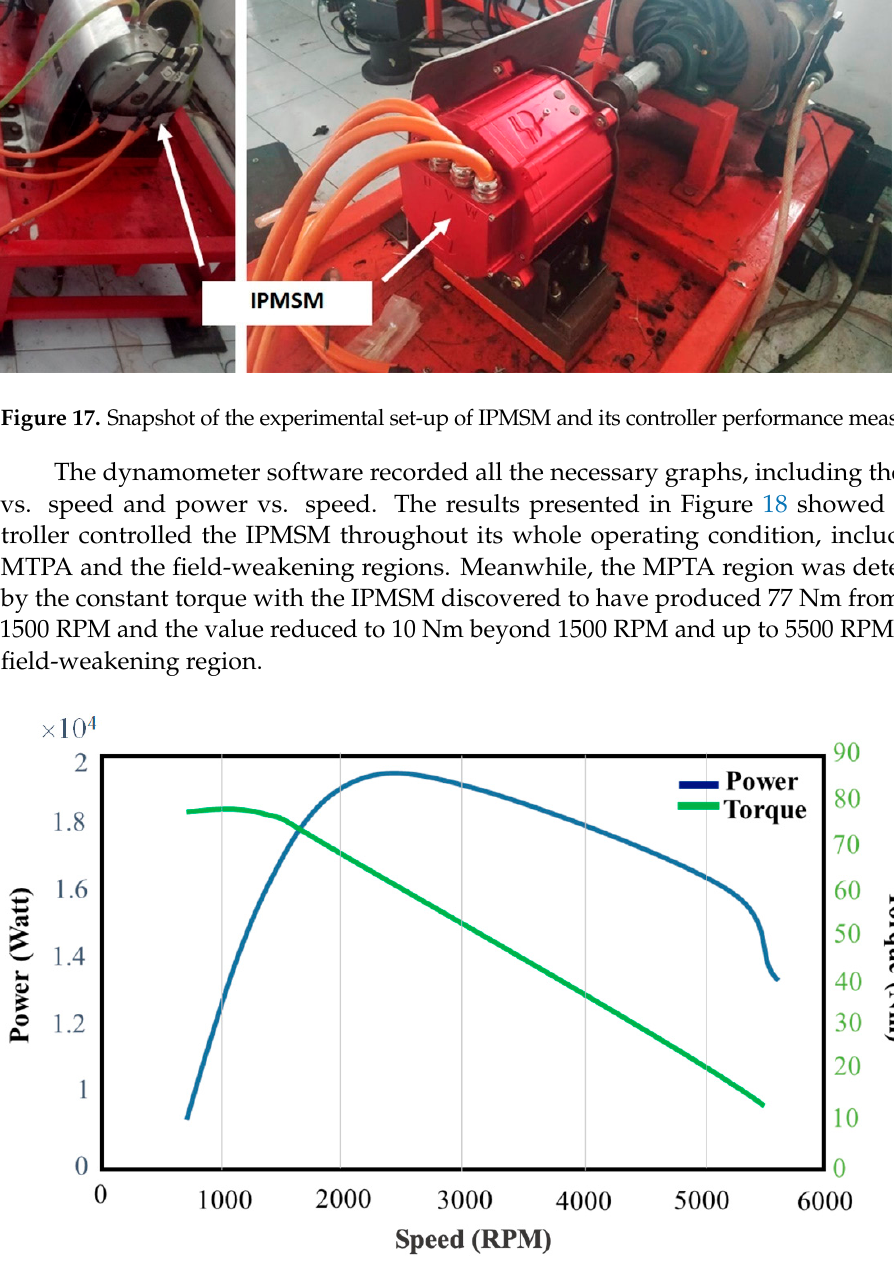
Figure 16. Experimental set-up of IPMSM and its controller performance measurement.